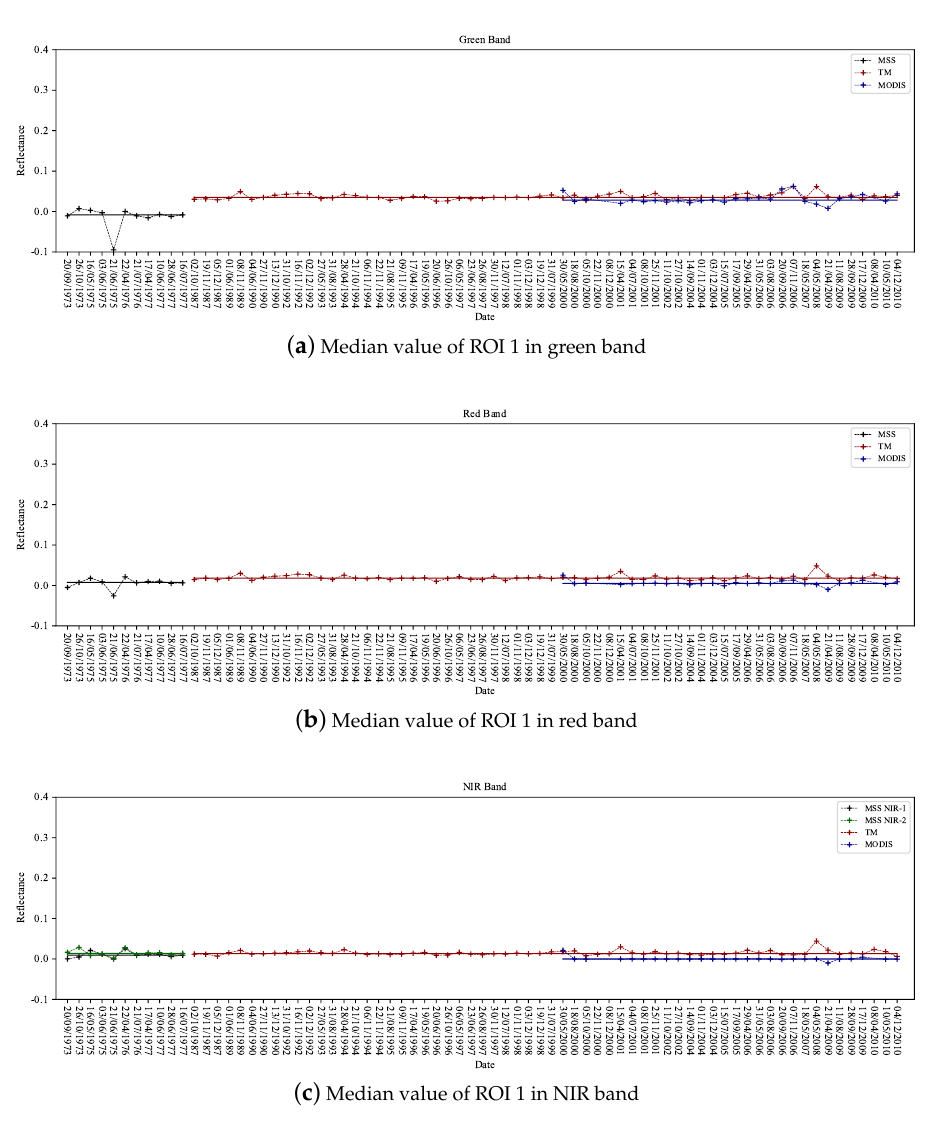
Figure 11. Time series of ROI 1 median value (ROI 1: water